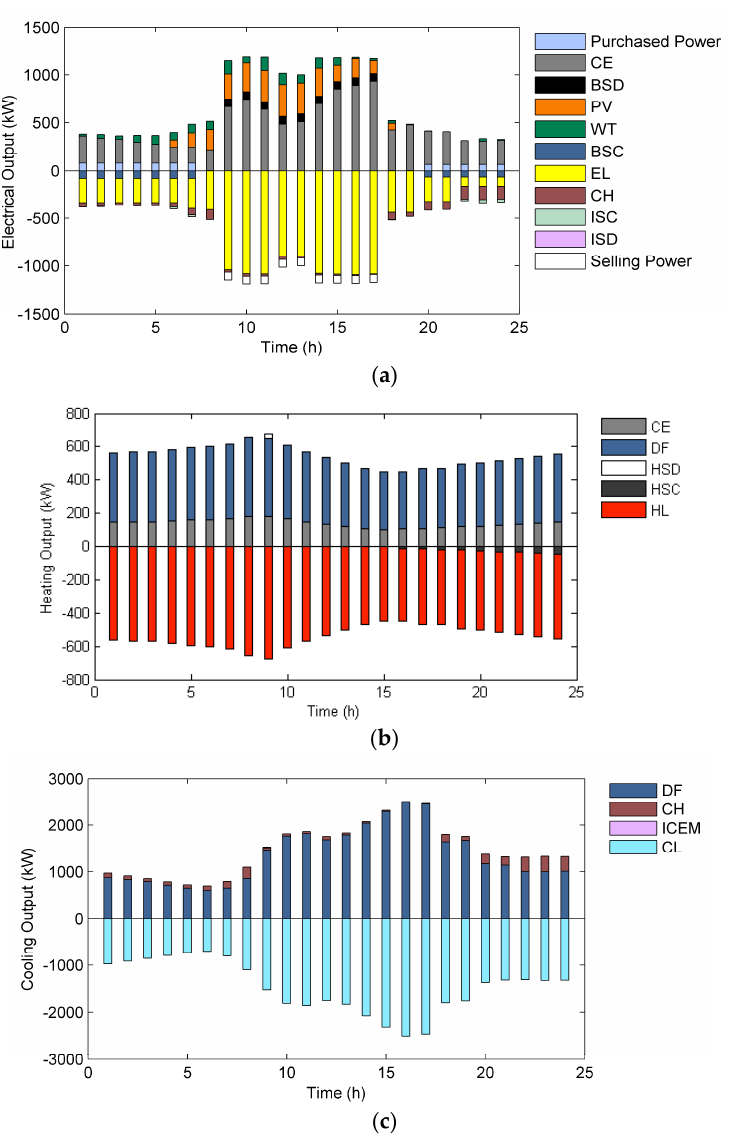
Figure 9. Optimal outputs of MEG in Scenario 2. ( a ) The optimal electrical outputs; ( b ) The optimal heating outputs; and, ( c ) The optimal cooling outputs.